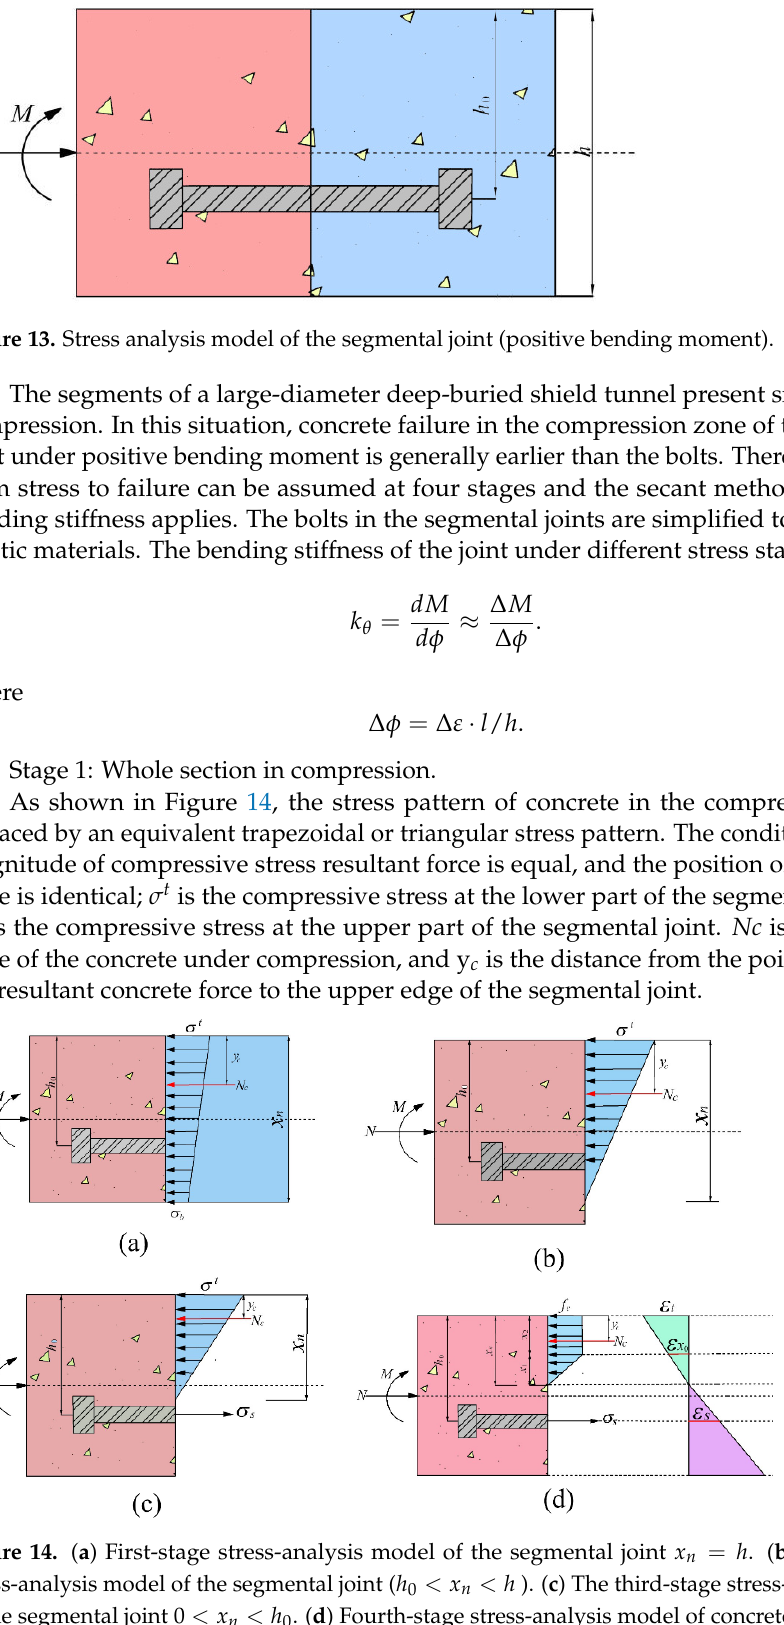
Figure 14. ( a ) First-stage stress-analysis model of the segmental joint x n = h . ( b ) Second-stage stress-analysis model of the segmental joint ( h 0 < x n < h ). ( c ) The third-stage stress-analysis model of the segmental joint 0 < x n < h 0 . ( d ) Fourth-stage stress-analysis model of concrete after yielding. Simplified balance equation: (7) The action point of resultant force: